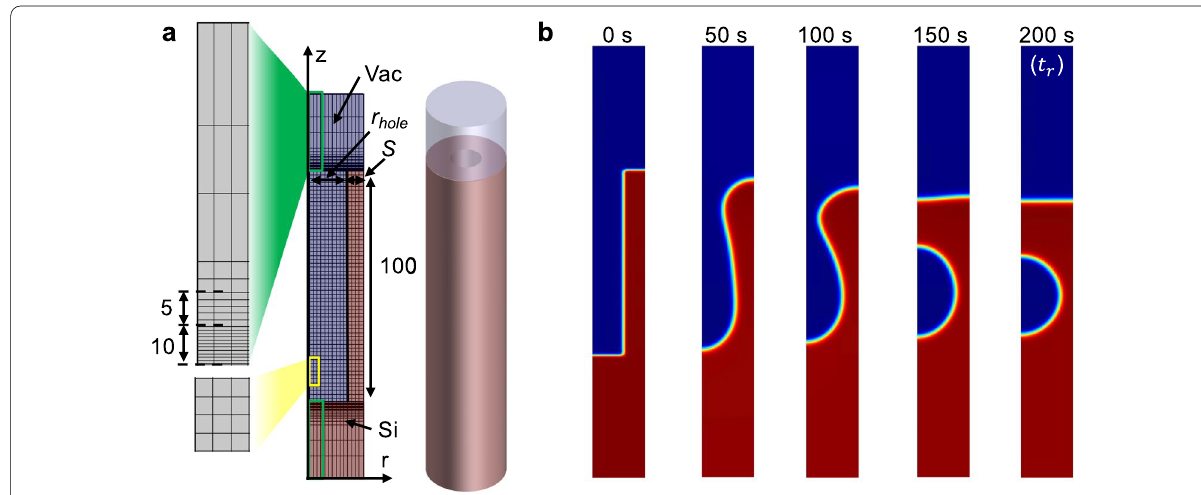
Fig. 2 Two-dimensional axisymmetric model of the reference case ( r hole = 0.5 µ m, AR = 3 , and S = 0.35 µ m); a geometry and mesh. b shape evolution of a single hole until the cavity becomes sphere. Simulation time of 200 s is considered as reference time ( t r ) for parametric